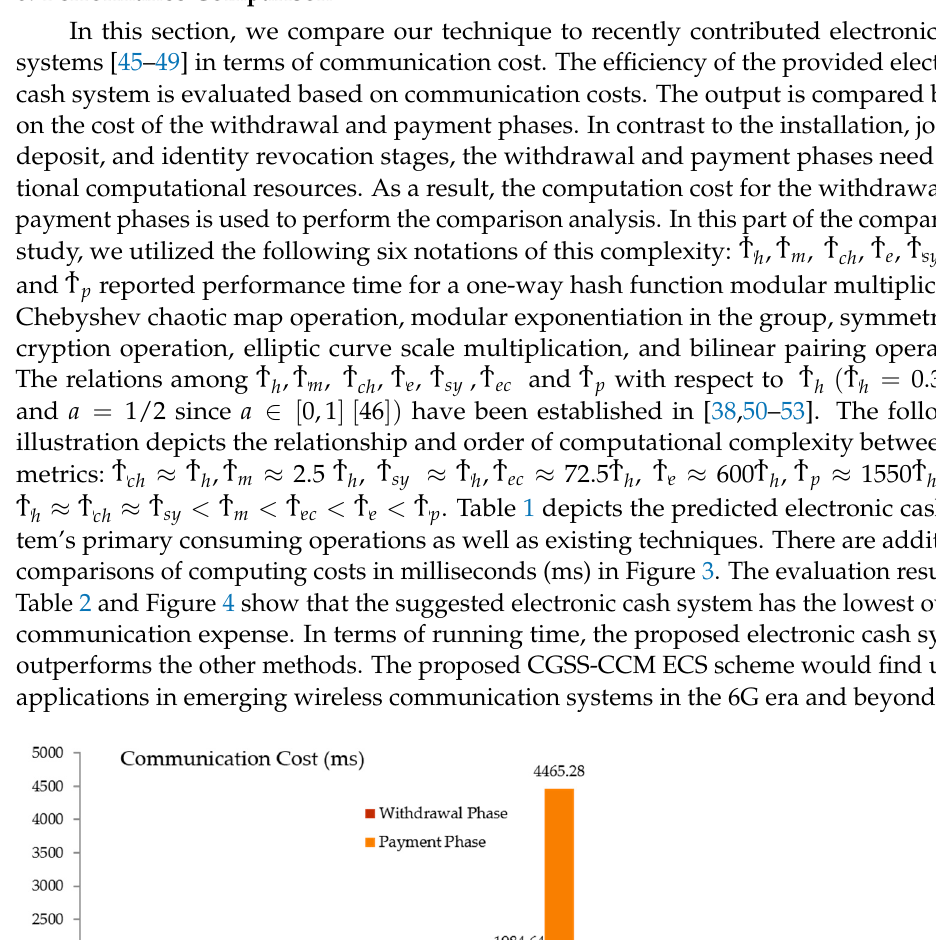
Table 2. Assessments of important operations with reverence techniques.